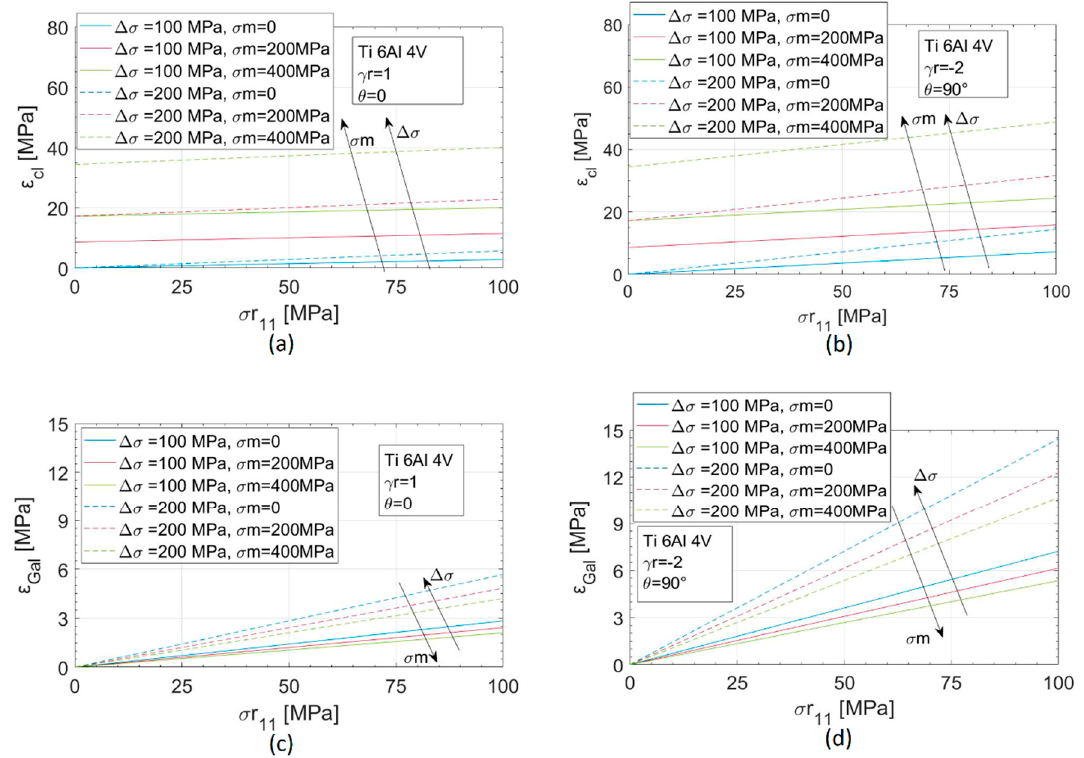
Figure 7. Parameter ε as function of σ r11 for the Ti6Al4V alloy: ( ε cl ) for the classical technique and ( ε Gal ) for the method proposed in Reference [17] are compared for the case of ( a , c ) for low and ( b , d ) for high residual stresses effect.